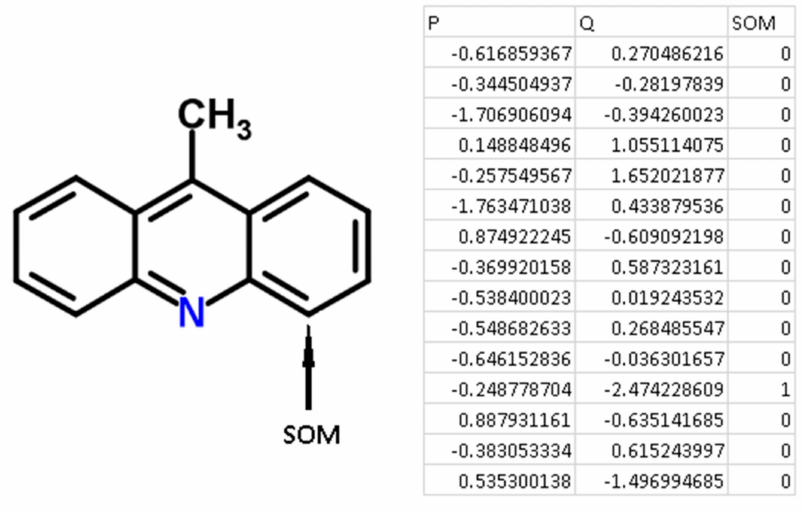
Figure 3. An example of the generation of QNA descriptors for the molecule